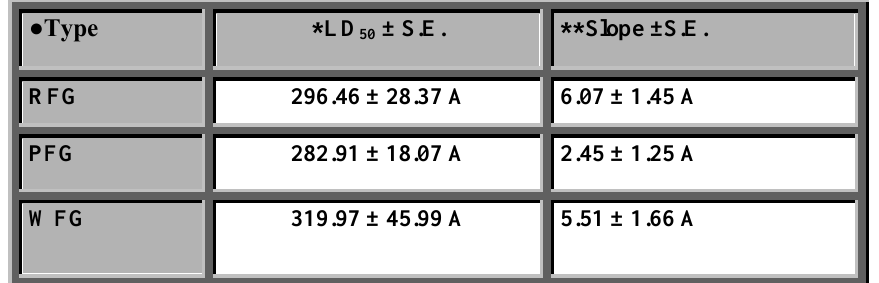
Fig 8:-Estimation log dose-probit curve for hexane extract of the WFG of N.oleander after fitting LD 319.979 mg/kg of body weight. Table 5:- values of LD and slope of the three preparations 50